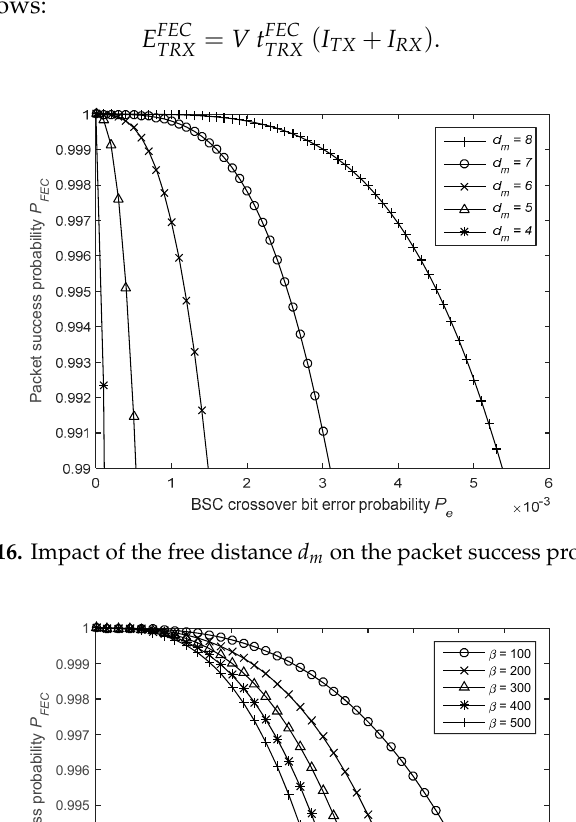
Figure 18. Impact of the number of blind transmission attempts on the packet success probability. Figure 18 shows the impact of 𝑅 on the packet success probability. When using BR, the required time to send a packet is given by 𝑡 (cid:3021)(cid:3019)(cid:3025)(cid:3019) = 𝑅 (cid:3039) (cid:3005) (cid:3267) + 𝑡 (cid:3036)(cid:3031) (𝑅 − 1) ,